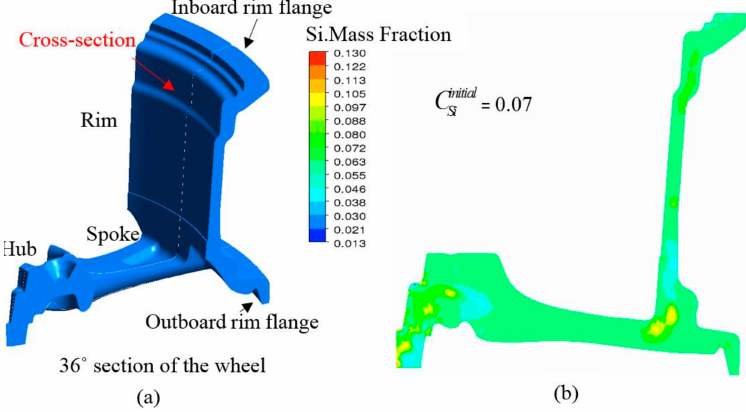
Figure 5. Location of the cross-section in the wheel domain ( a ) and the silicon mass fraction contour predicted by the model at 72 s ( b